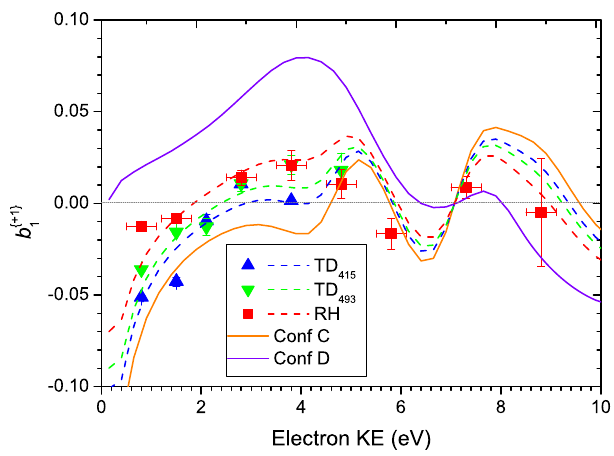
Fig. 7 Type I conformer (C + D) b fþ 1 g values for the HOMO orbital 1 photoionization as a function of electron KE. The mean experimental b fþ 1 g data points, given by symbols, extracted from total (parent + 1 fragment) mass- fi ltered TD 415 , TD 495 , RH data sets using a gaussian sampling function centered at 8.75 eV binding energy, are shown for L -Pro with any D -Pro data negated prior to plotting. Horizontal error bars are attached to the RH data only, representing the FWHM of the gaussian sampling function that isolates the Type I region; the same FWHM was also used for the TD data sets but for clarity has not been explicitly shown. Vertical error bars correspond to statistical (standard deviation) errors. Also included are solid curves showing the CMS-X α calculations for conformers C and D. Best fi ts to the experimental data sets obtained by combining these predictions (see text) appear as broken lines.